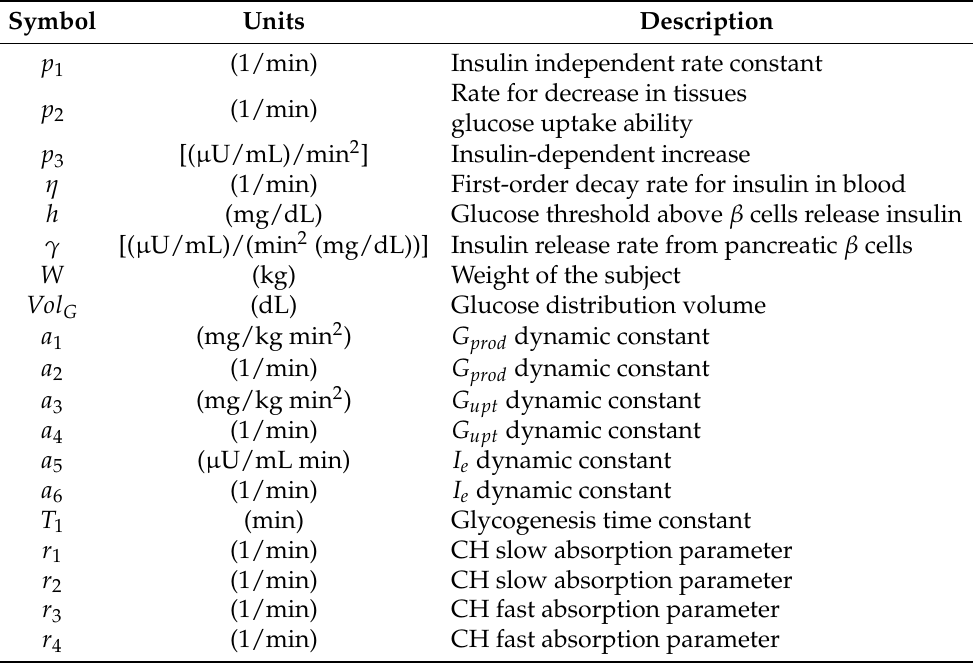
Table 1. Parameters description of the Extended Bergman minimal model.